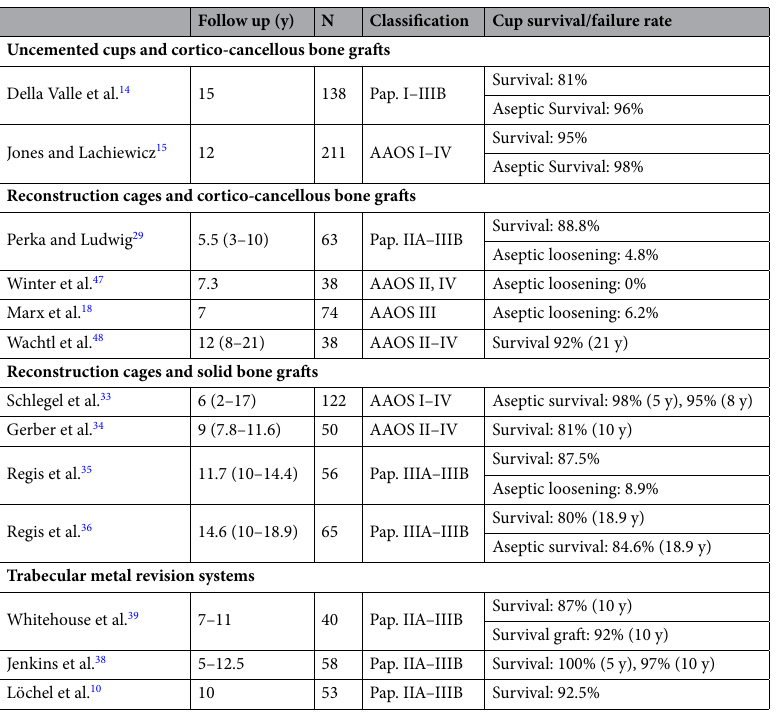
Table 3. Review of cup survival in